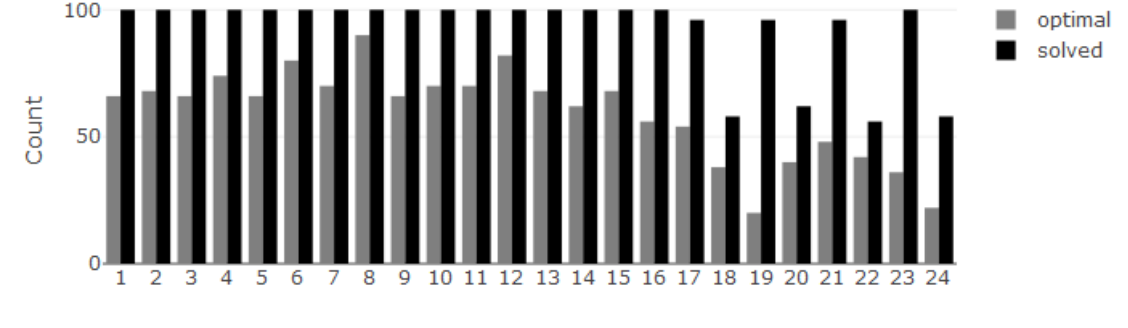
Figure 4. Percentage of solved instances for each case, with the main model (gray bar) or with one of the two models (black bar).